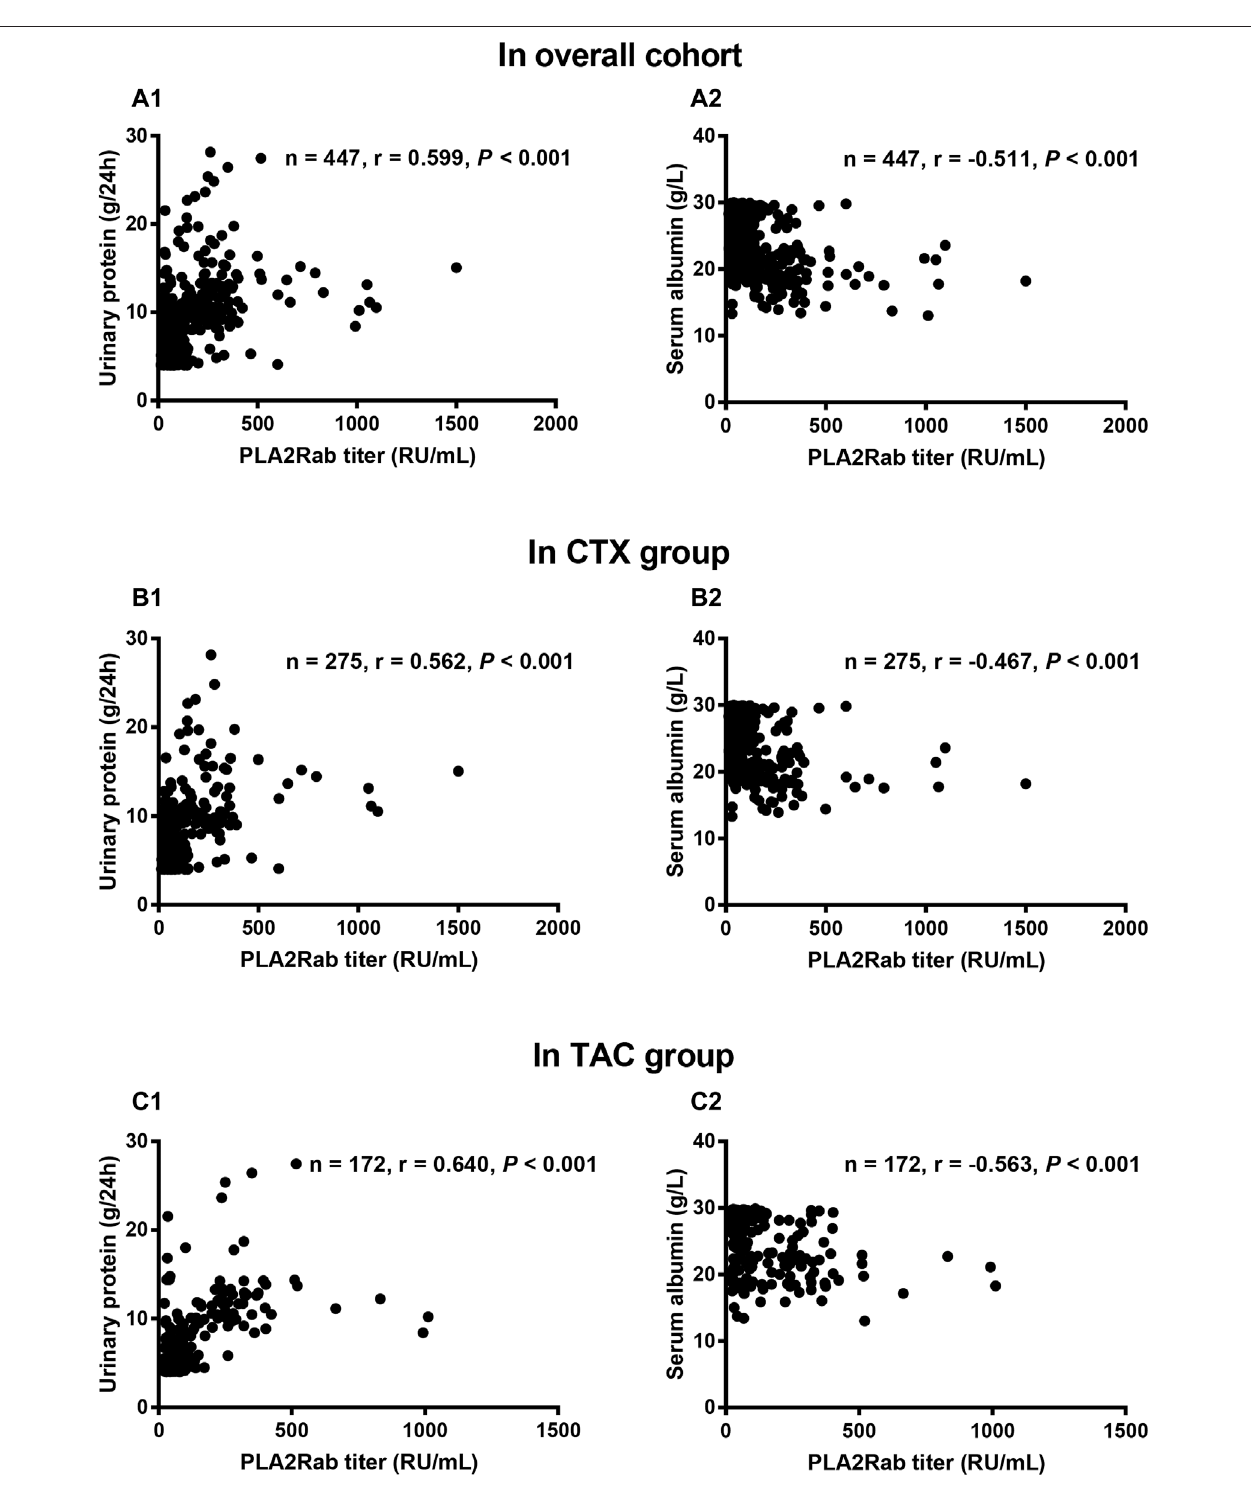
FIGURE2| CorrelationanalysesbetweenserumPLA2Rabtiterandurinaryproteinandserumalbumin.TheserumPLA2Rabtiterpositivelyassociatedwithurinary proteininoverallcohort (A1) ,CTXgroup (B1) ,andTACgroup (C1) ;butnegativelyassociatedwithserumalbumininoverallcohort (A2) ,CTXgroup (B2) ,andTACgroup (C2) . CTX: cyclophosphamide; TAC: tacrolimus; PLA2Rab: antibody against the M-type phospholipase-A2-receptor.